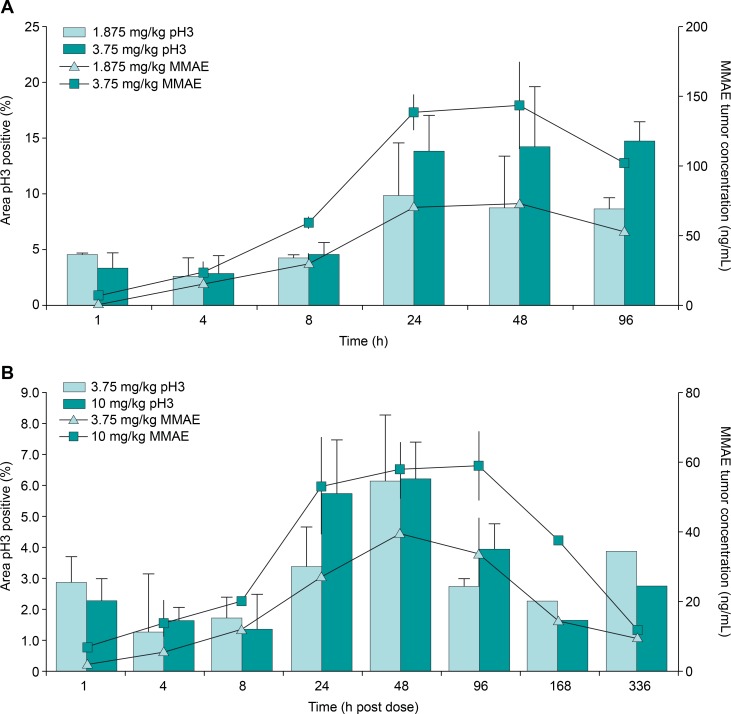
Phospho-histone H3 and MMAE levels in HEK293-GCC and PHTX-09c xenograft tumors following TAK-264 treatment.(A) HEK293-GCC and (B) PHTX-09 xenograft tumors were harvested at the indicated times post-treatment, with three animals per time point. Control tumors were taken from three untreated mice. The average percentage of phospho-histone H3-positive cells and average level of MMAE tumor concentration are plotted, with error represented as standard deviation. GCC, guanylyl cyclase C; MMAE, monomethyl auristatin E.